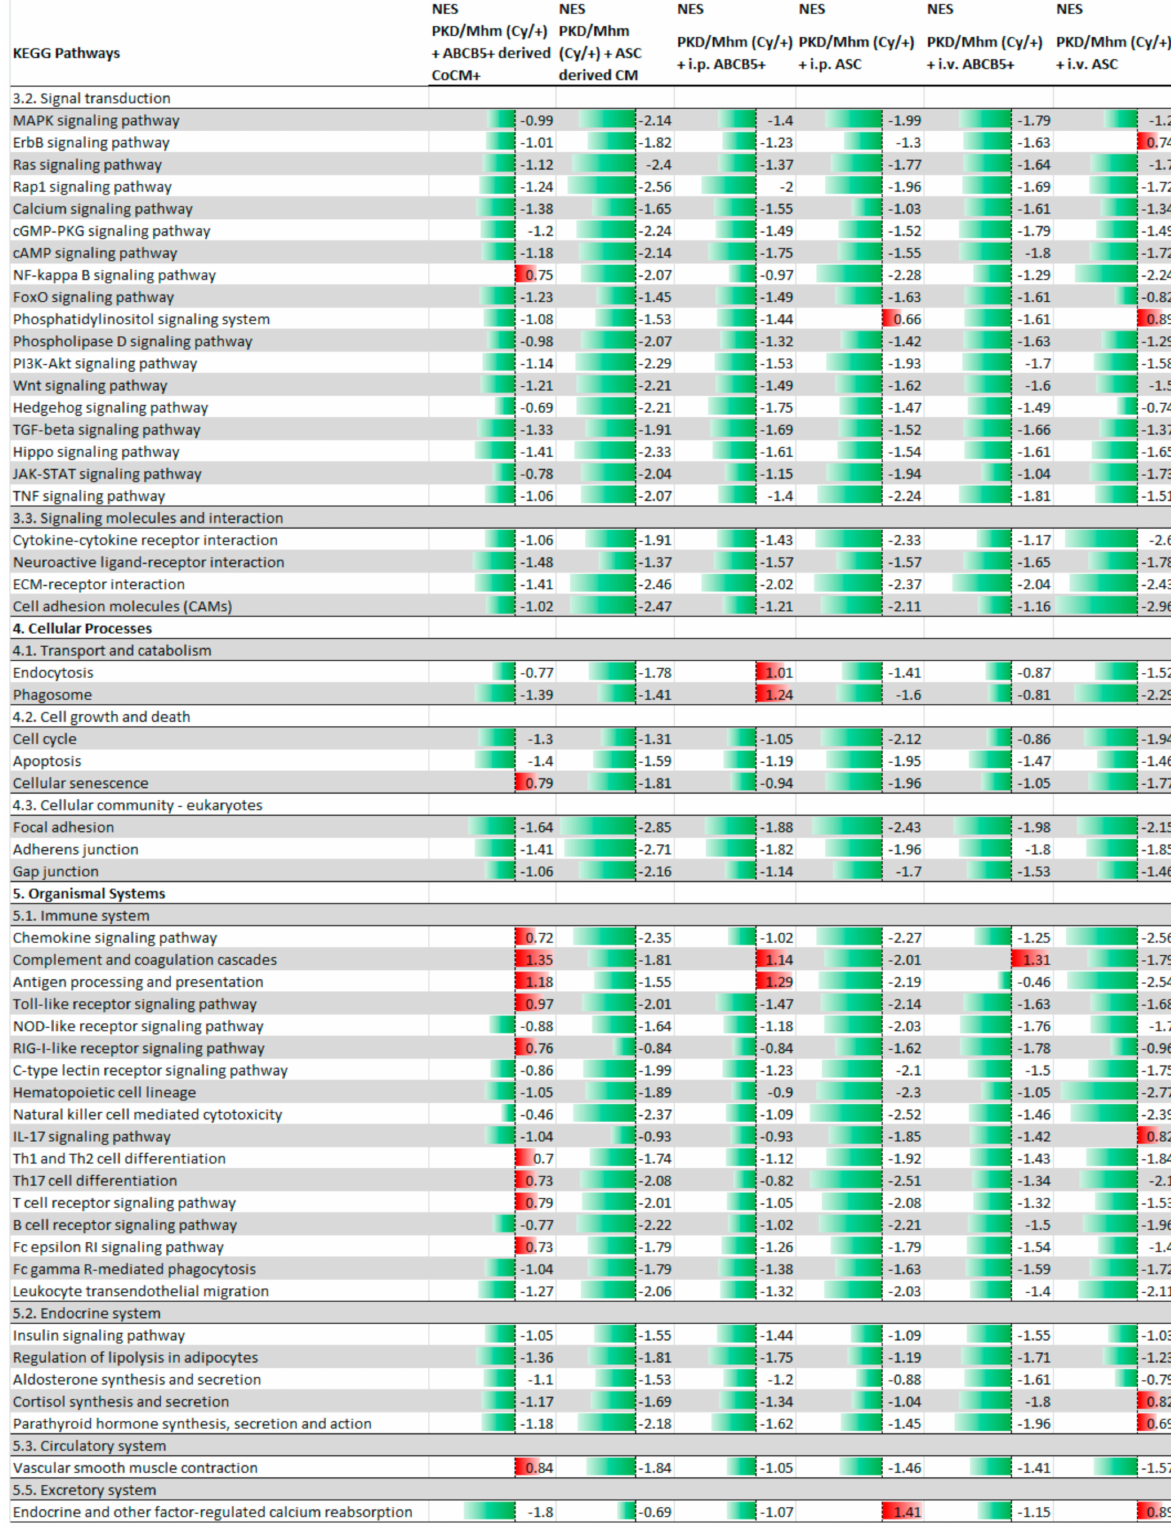
Figure 2. GSEA analysis using KEGG database. Principal downregulated pathways in i.v. ABCB5 + ; i.p. ABCB5 + ; ABCB5 + —derived CoCM + ; i.v. ASC groups; i.p. ASC and ASC—derived CM groups. Significantly ( adj. p < 0.05) differentially expressed pathways (PKD/Mhm (Cy/+) + treatment vs. PKD/Mhm (Cy/+)). Data are sorted by main categories. NES is given for each